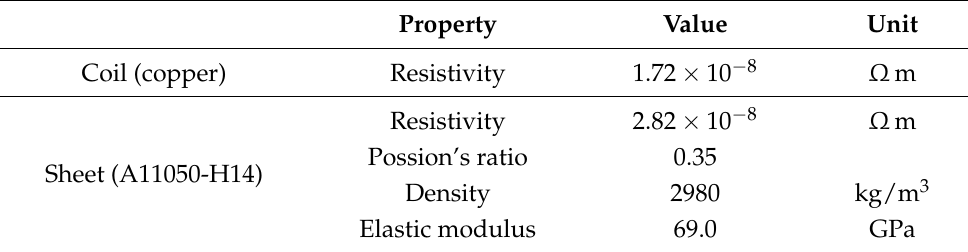
Table 1. Material properties for EMF numerical